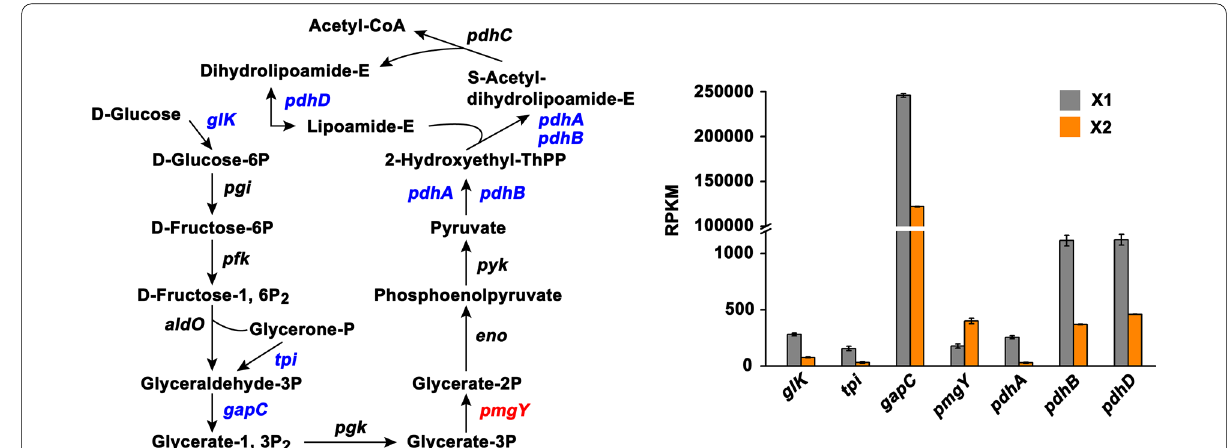
Fig. 8 Changes in the expression of genes implicated in glycolysis. The upregulated and downregulated genes were denoted as red and blue texts, respectively. Expression level shown as RPKM was displayed by mean in Additional file 1: Table